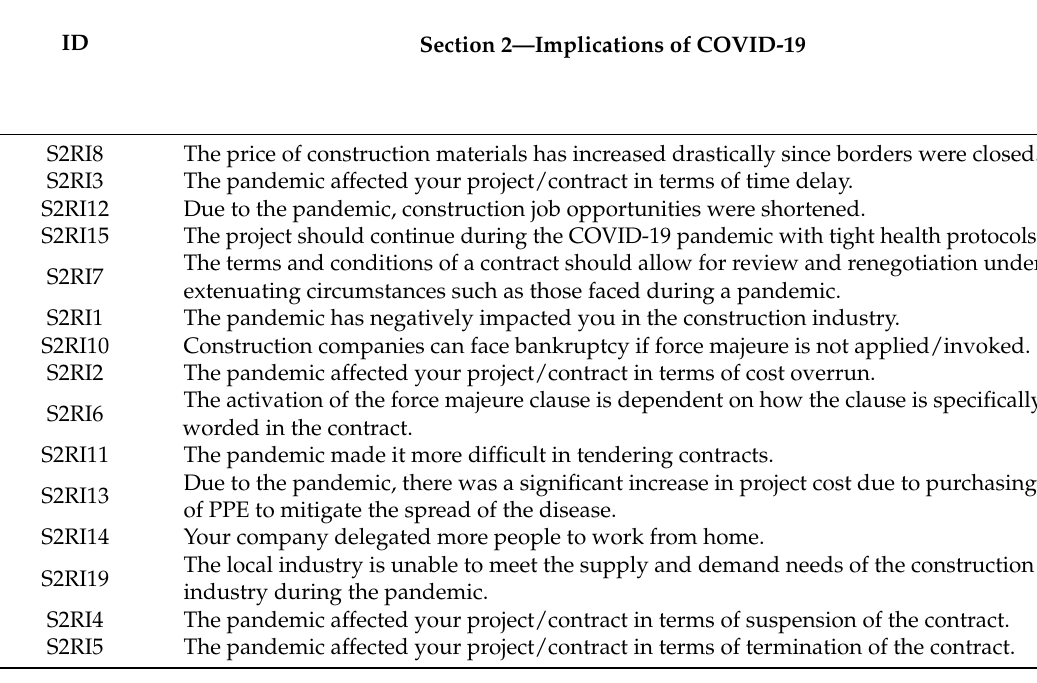
Section 2—Implications of